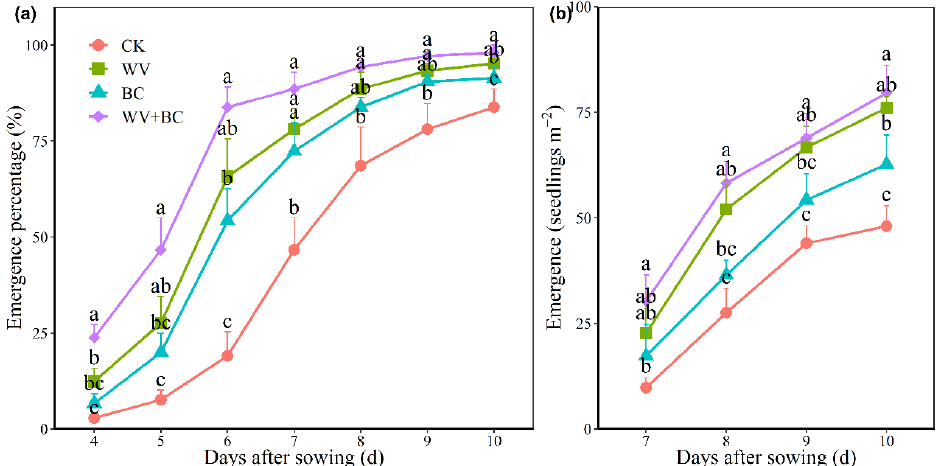
Figure 3. Emergence dynamics of different seed treatments of WDR under dry direct-seeded system. ( a ) growth chamber experiment. ( b ) field experiment. Different letters show a significant difference between treatments at p = 0.05 according to LSD test. Error bars indicate standard error of three replicates. CK: untreated seeds, WV: wood vinegar seed priming, BC: biochar seed coating, WV + BC: co-treatment of wood vinegar priming and biochar coating. Table 3. Emergence characteristics of different seed treatments of WDR under dry direct-seeded system.